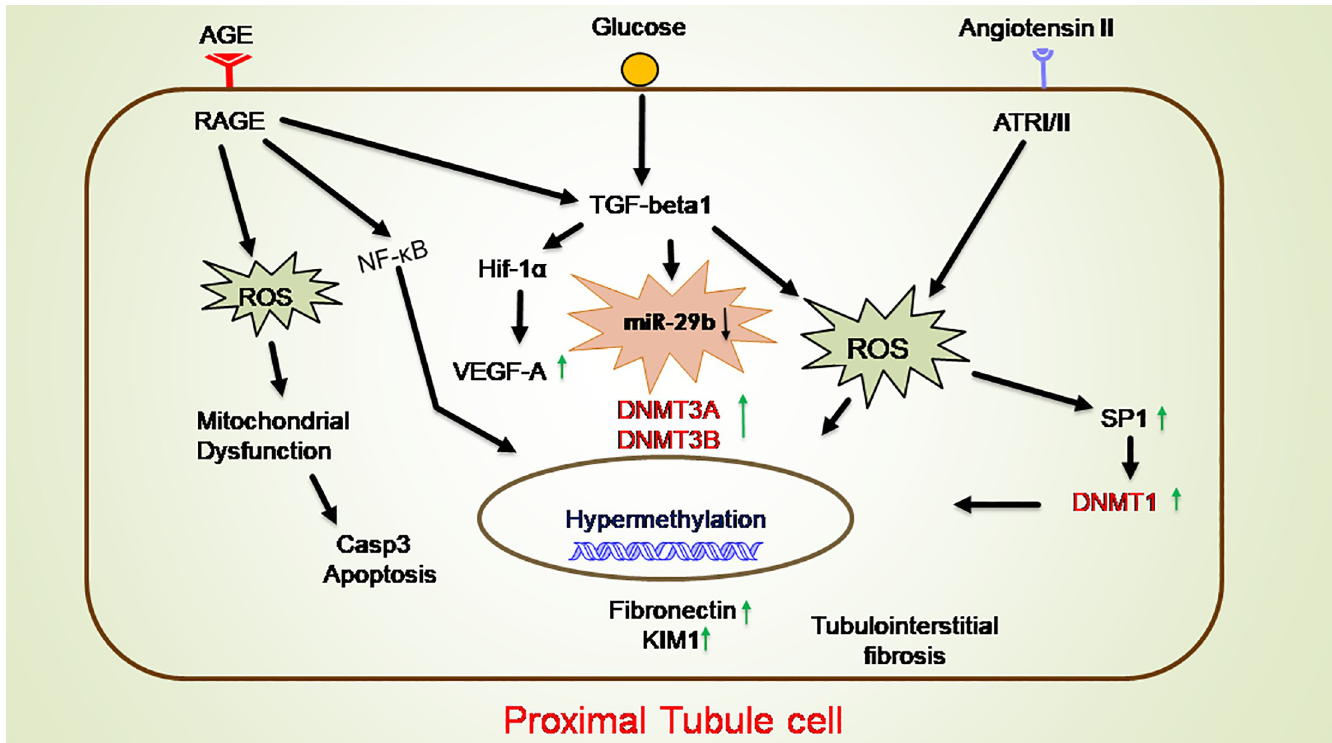
Fig 11. Graphical conclusion. Hemodynamic factor (Ang-II) and metabolic factors (AGE and Glucose) are modulating expression of inflammatory markers like TGF- β 1, NF- κ B and IL-6 and oxidative stress markers like ROS. Because of increased expression of TGF- β 1 there is downregulation of miR29b which leads to dysregulation of methylation and as a result causes hypermethylation of